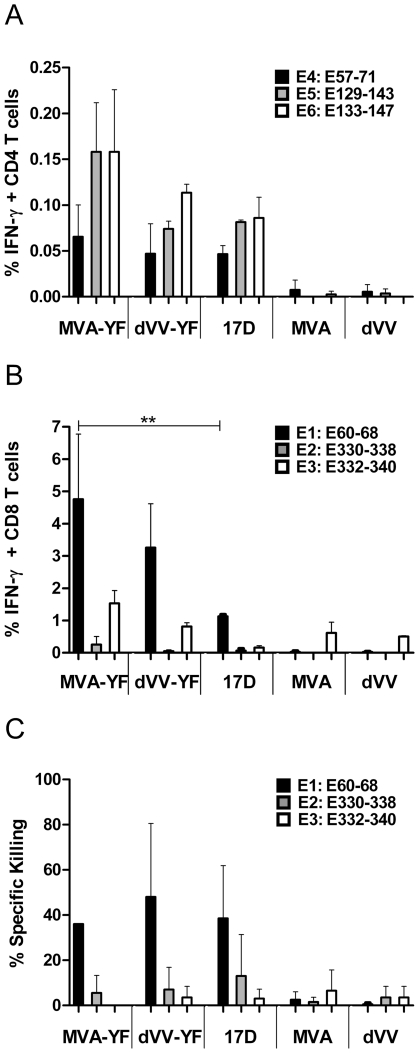
Cellular immune response elicited against YFV E-antigen.(A) FACS analysis of the number of IFN-γ secreting CD4+ T-cells after two immunizations with MVA-YF, dVV-YF or the corresponding YFV-17D (17D) positive or wild-type MVA and dVV negative controls. Splenocytes from mice were stimulated with 15mer peptides of the YFV E-protein, E57–71 (E4; black bars), E129–143 (E5; grey bars) and E133–147 (E6; white bars). (B) FACS analysis of the number of IFN-γ secreting CD8+ T cells after the two immunizations as indicated above. Splenocytes from mice were stimulated with 9-mer peptides of the YFV E-protein, E60–68 (E1; black bars), E330–338 (E2; grey bars), E332–340 (E3 white bars); ** p<0.001. (C) FACS analysis of cytotoxic killing of peptide-pulsed target cells by specific CD8+ T cells. Target cells were loaded with 9mer peptides of the YFV E-protein, E60–68 (E1; black bars), E330–338 (E2; grey bars), E332–340 (E3 white bars). The data are mean values (+/− SD) of two independent experiments.